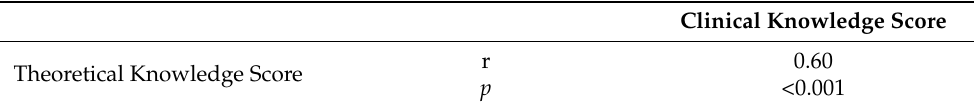
Table 7. Correlation between theoretical and clinical knowledge scores.